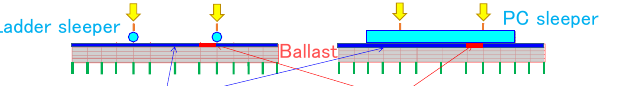
Figure 13. Outline of evaluation point.